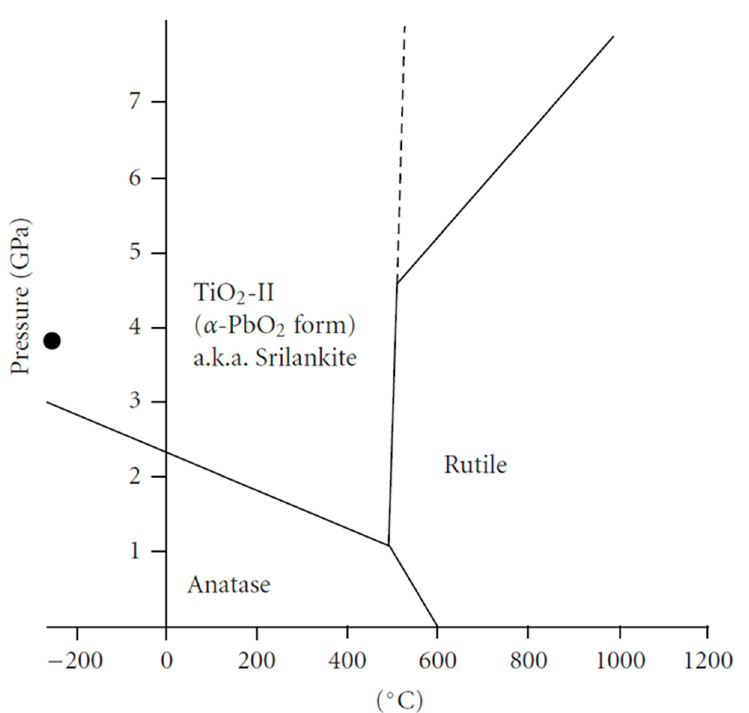
Figure 7. TiO 2 phase transition diagram from [144] (reproduced with permission from X. Nie et al., International Journal of Photoenergy; published by Hindawi Publishing Corporation, 2009, open access).